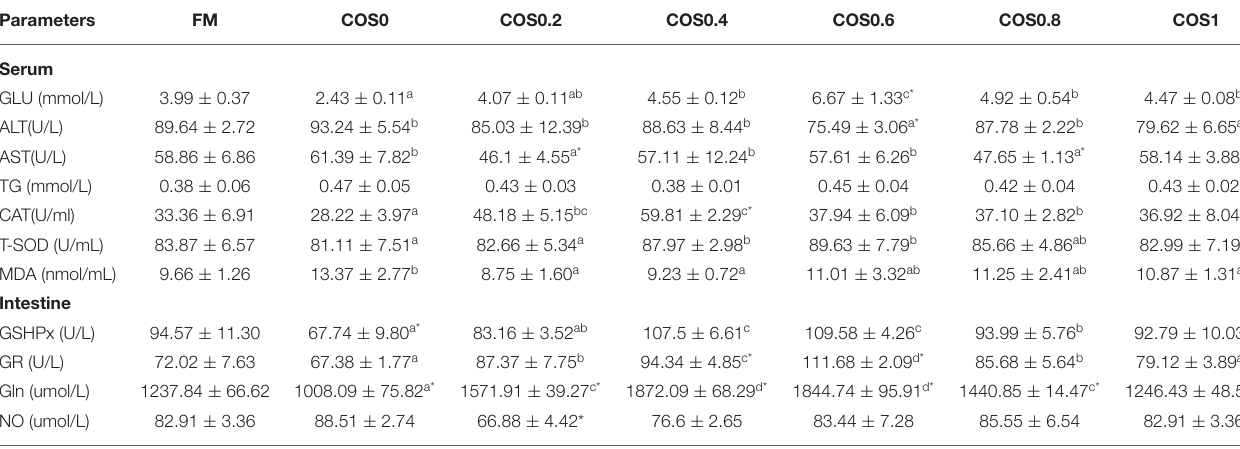
TABLE 5 | Serum and intestinal antioxidant indices of hybrid grouper fed with experimental diets for 8 weeks. Parameters